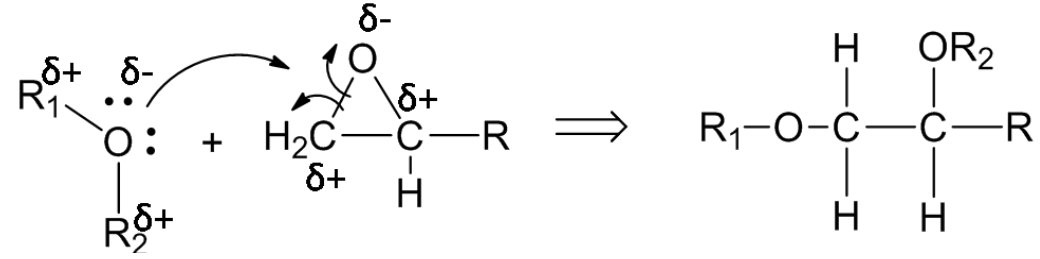
Figure. 9. Chemical reaction between oxygen-containing surface groups and the epoxide ring or the pre-polymer epoxy